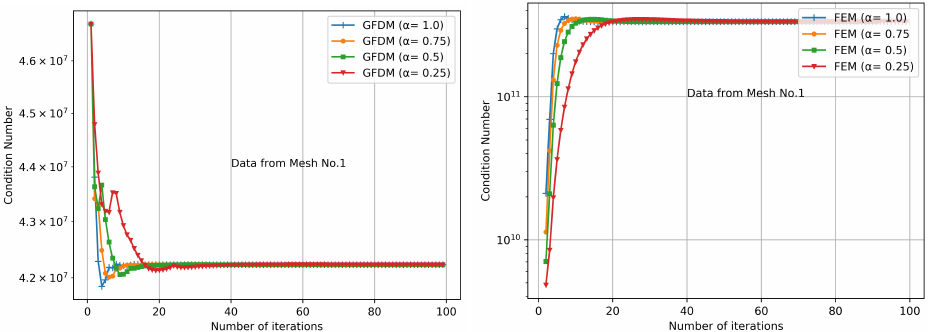
Figure 11. Jacobian condition number history on mesh no. 1 (coarse mesh).